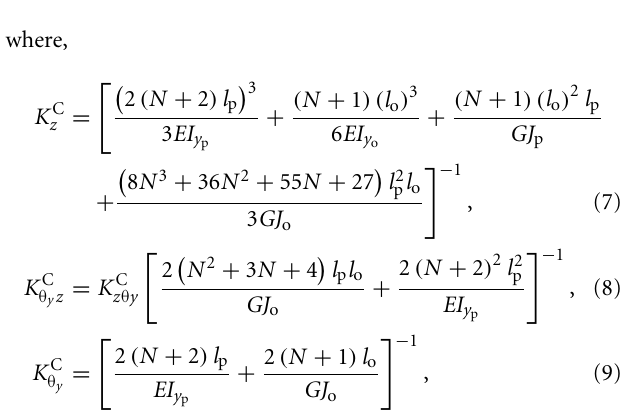
parallel to x -axis ( m 4